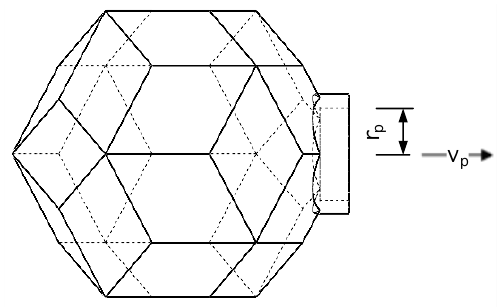
Figure 8. Jetting process of the rhombic triacontahedron origami flexiball.